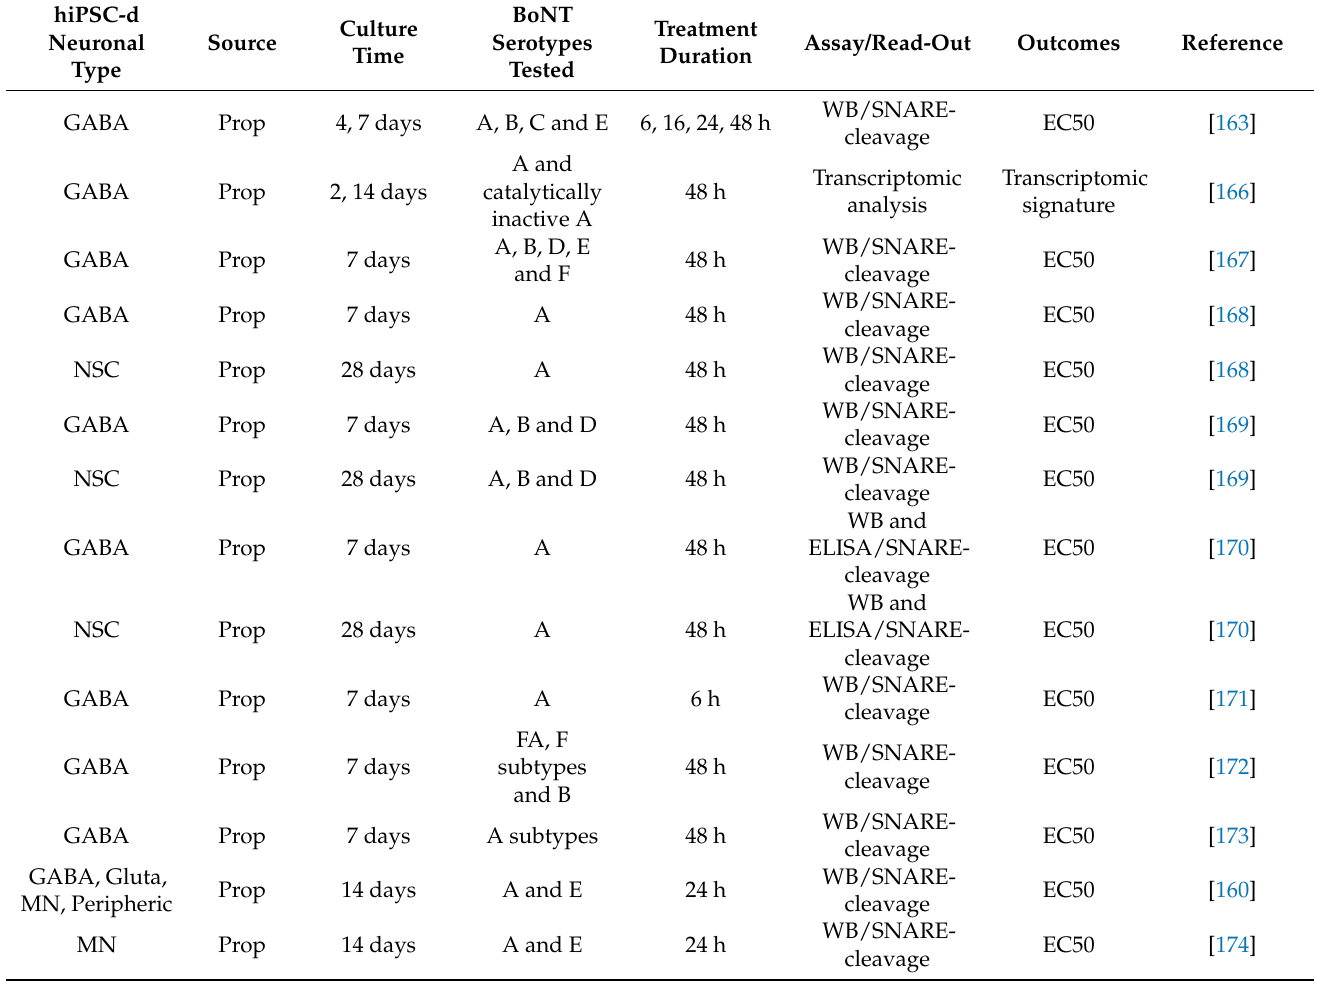
Table 3. Use of hiPSCs for BoNT